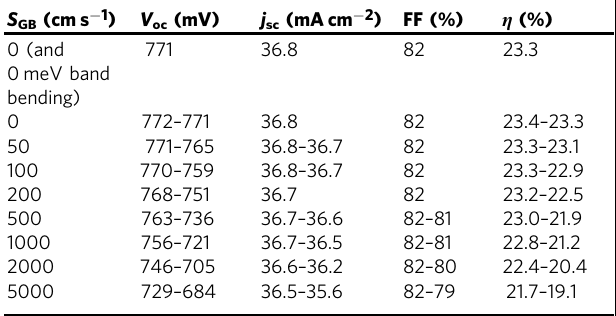
Simulated solar cell parameters based on the material parameter values given in Supplementary Table 3 and using S GB values ranging from 0 to 5000cms − 1 as well as including upward band bending of + 50meV (upper limit) and downward band bending of − 50meV (lower limit of